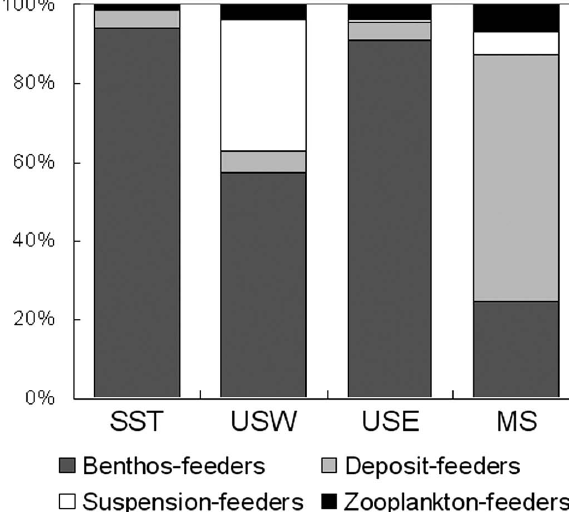
Fig . 7. – Invertebrate species trophic guild composition in the clus- ter groups in